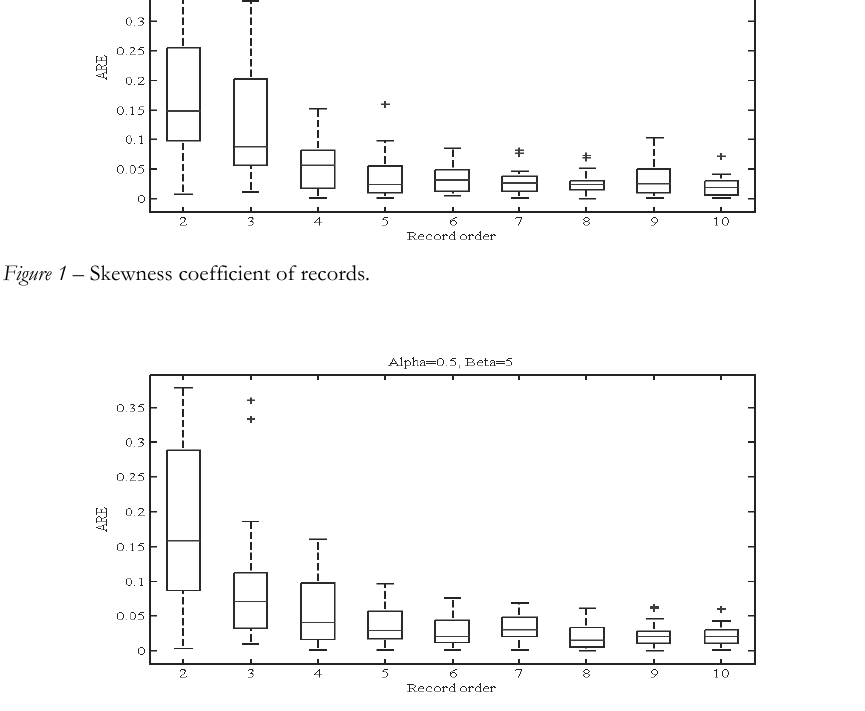
Figure 2 – Skewness coefficient of